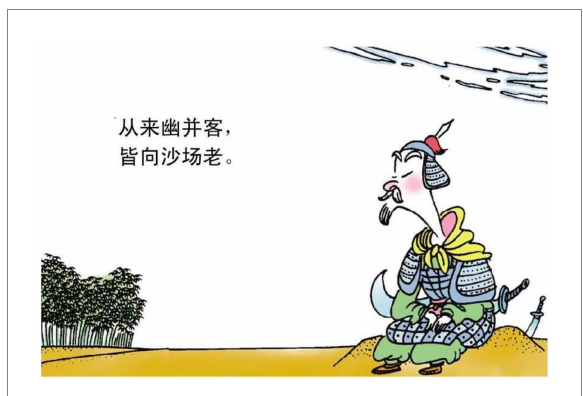
FIGURE 7 The forth panel on Cai (2014, p. 30). Images reproduced with permission from Shang Dong People Press.